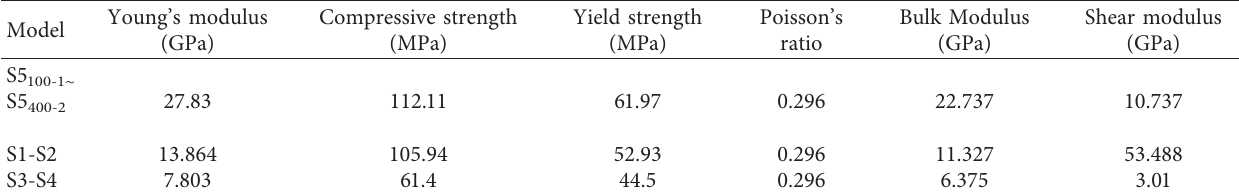
Table 1: Input parameters of numerical simulation.